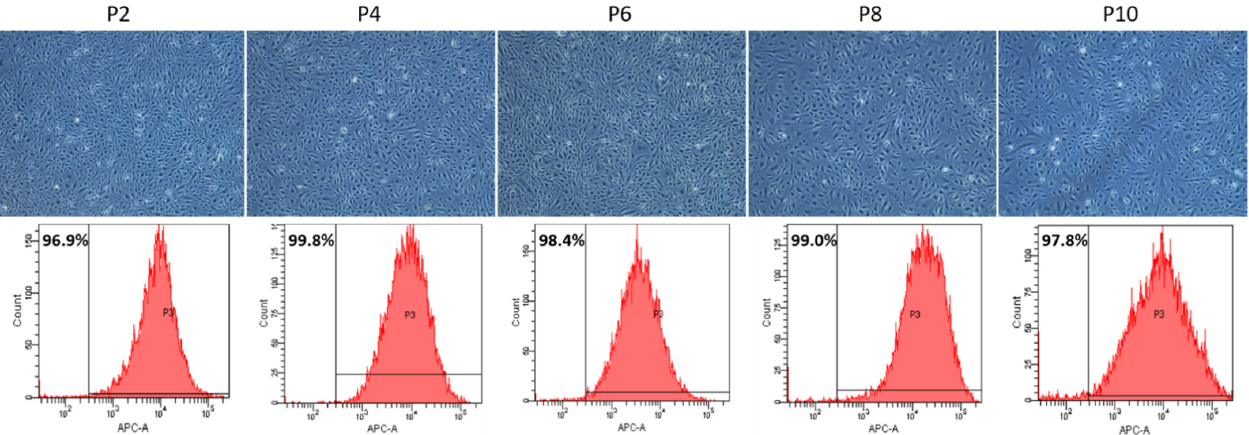
Figure 2. Representative pictures of PAECs showing shape, structure and cobblestone aspect of PAECs throughout subcultures ( upper panel ). Quantitative analysis of CD31-positive PAECs by flow cytometry throughout subcultures ( lower panel ). Scale = 200 µm.